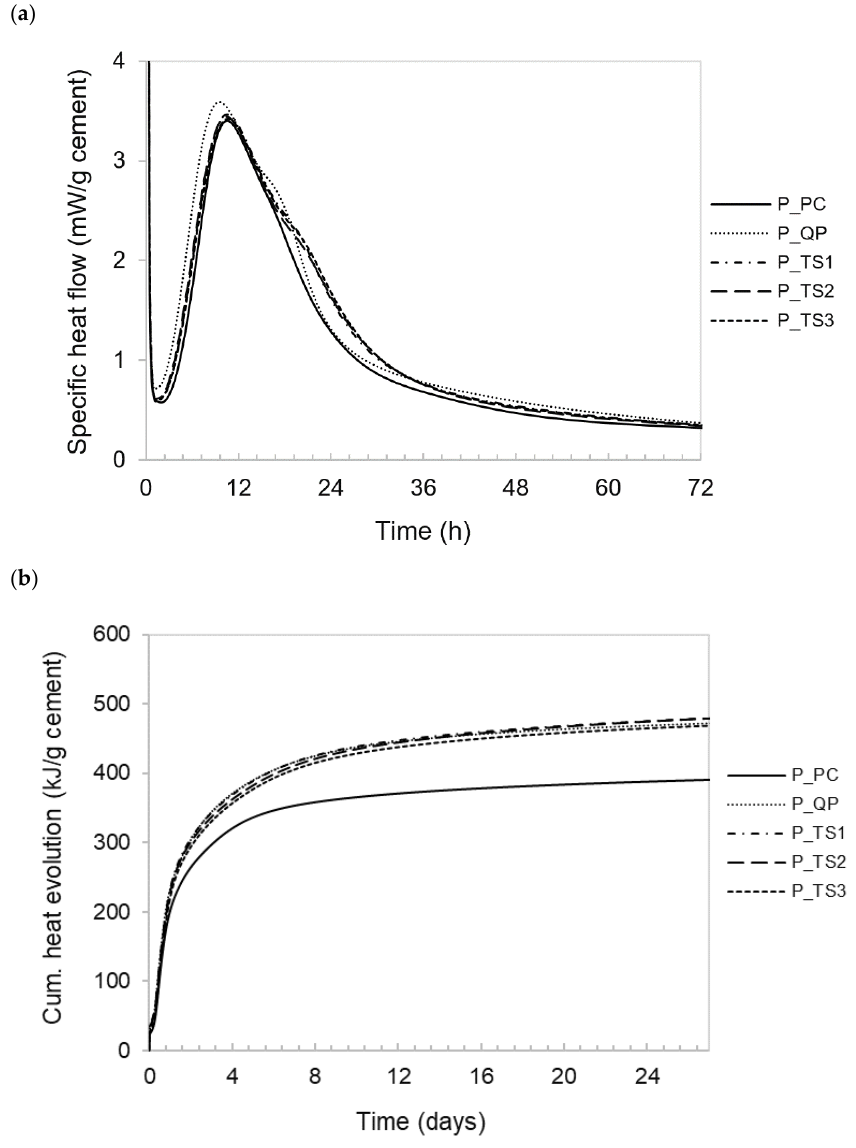
Figure 4. The specific heat flow and cumulative heat patterns of the pastes per gram of cement ( a ) in 24 h and ( b ) in 7 days.